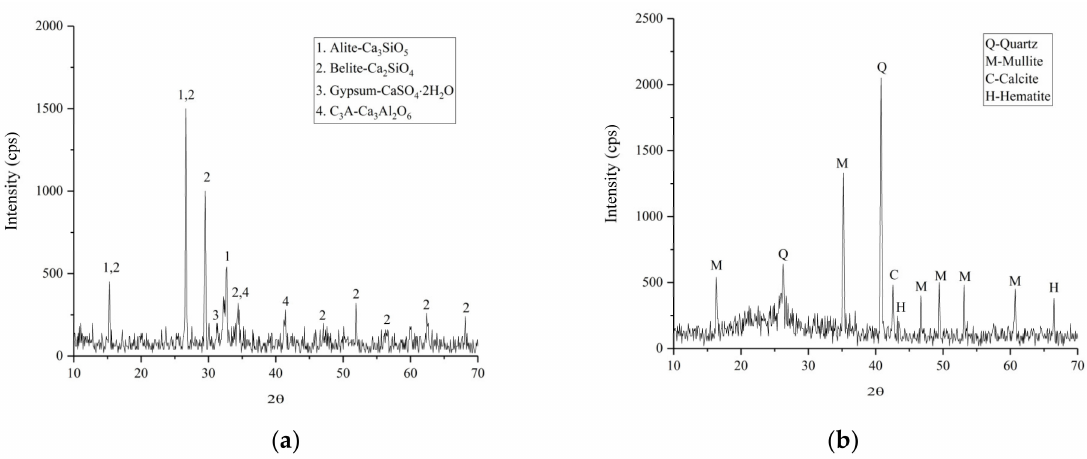
Figure 3. XRD analysis of the UC and UFA: ( a ) UC; ( b )